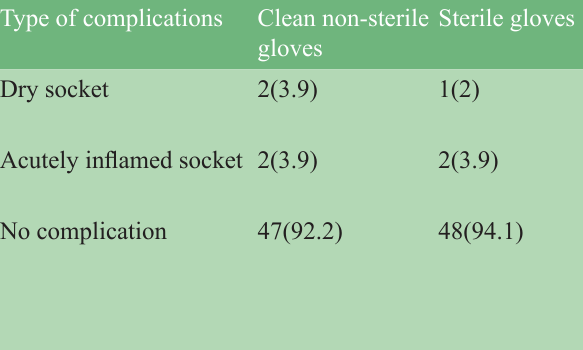
Table 2. Type of complications in both